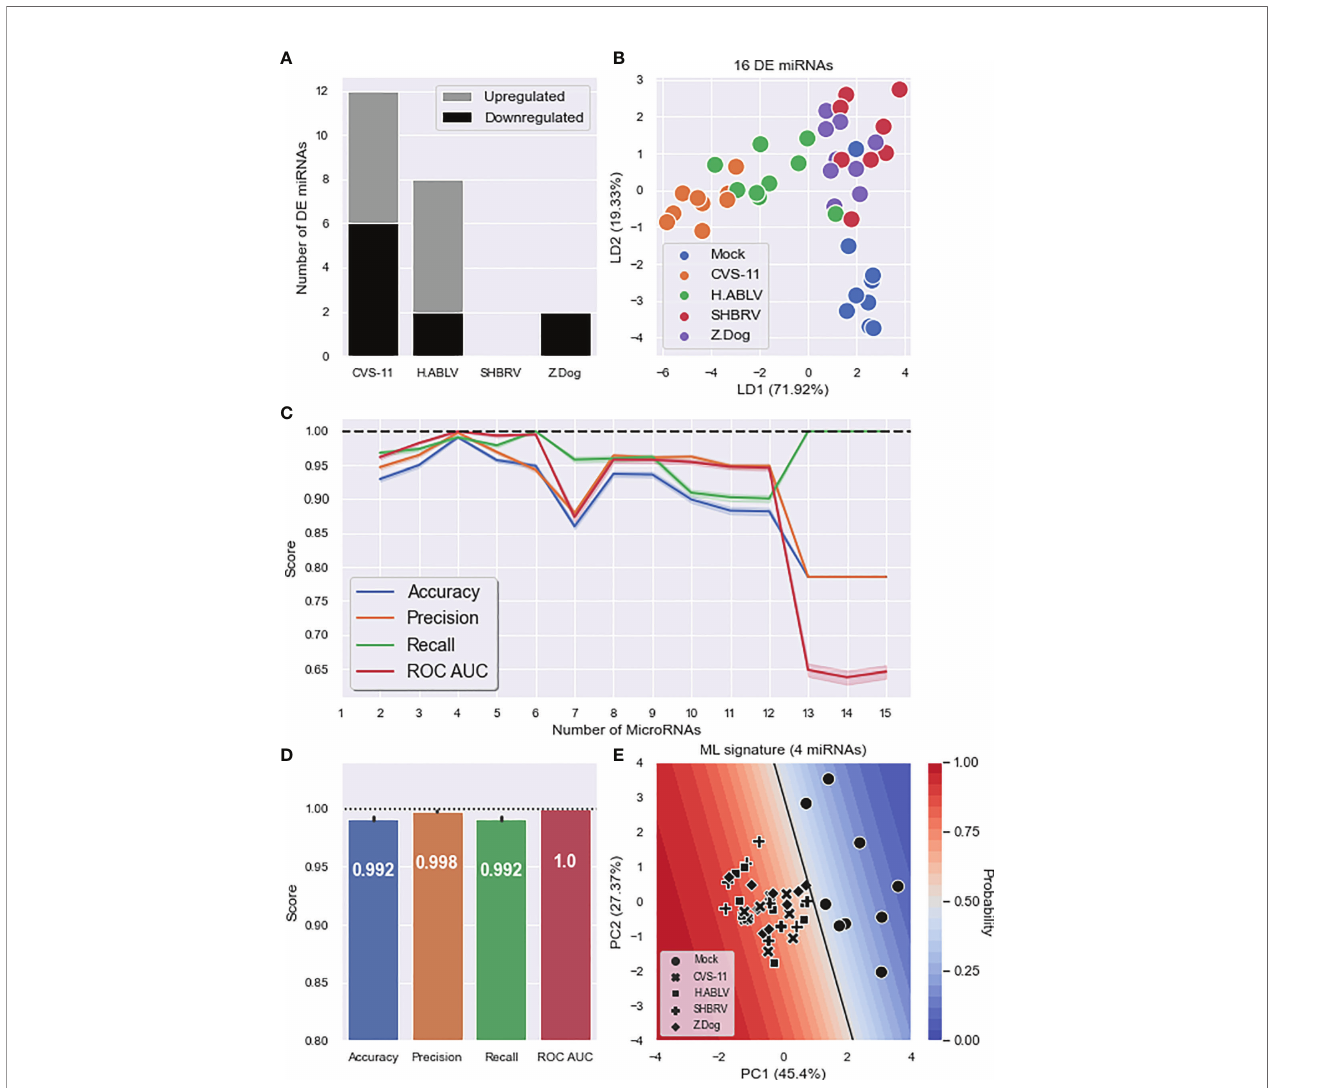
FIGURE 4 | Exosomal miRNA composition changes during neuronal lyssavirus infection. (A) Stacked barplot showing the number of DE HDF51i-509 neural exosomal miRNAs (upregulated – grey, downregulated – black) identi fi ed in response to each lyssavirus strain compared to a mock infection. (B) Linear discriminant analysis (LDA) scatterplot using all 16 DE miRNAs identi fi ed in at least one lyssavirus strain. Groups are Mock infection (blue), CVS-11 (orange), H.ABLV (green), SHBRV (red), and Z.Dog (purple). N = 9 technical replicates in each group obtained from three separate biological experiments. (C) Feature (miRNA) selection lineplot showing the impact of increasing numbers of miRNAs on the performance of a logistic regression model. MicroRNAs were selected using recursive feature elimination to identify the most important miRNAs. Each combination of miRNAs was randomly assessed 1,000 times. Shaded areas are the 95% CI, and the dotted line is a perfect (100%) score. (D) Barplot showing the average performance metrics of the 6-miRNA ML signature in classifying mock infection and lyssavirus-infected neural cell culture. Error bars are the 95% CI after 1,000 random iterative assessments. Dotted line is 100%. (E) Decision boundary graph showing the logistic regression decision point (solid black line) and the probability neural cells are infected with lyssavirus based on the exosomal miRNA signature (blue to red shading). Datapoints are mock infection (circles), CVS-11 (crosses), H.ABLV (squares), SHBRV (plusses), and Z.Dog (diamonds) neural cell